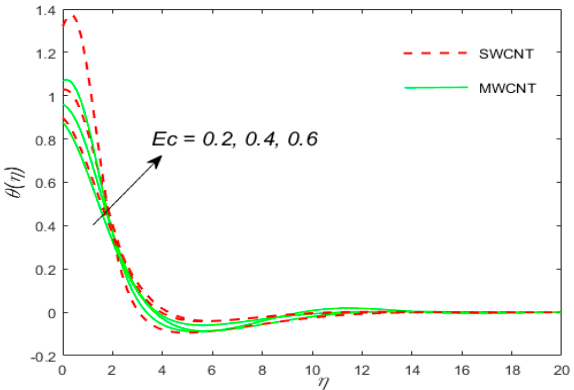
Figure 9. The impact of the temperature distribution profile θ ( η ) for the case of SWCNT and MWCNT versus the similarity variable for the distinct values of the radiation parameter R d . Coatings 2020 , 10 , x FOR PEER REVIEW